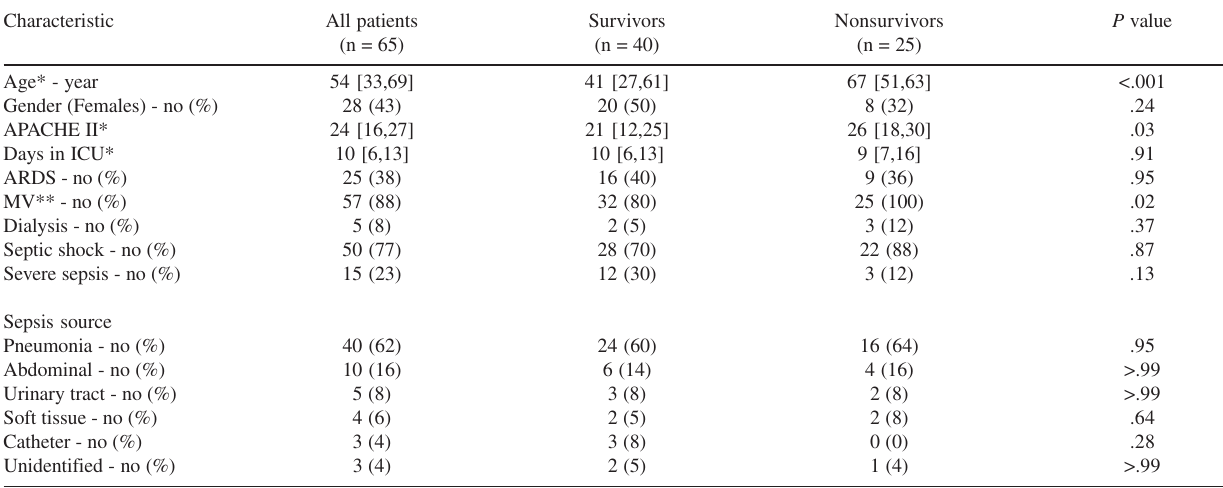
Table 1 - General characteristics of survivors, nonsurvivors, and the whole group Characteristic All patients